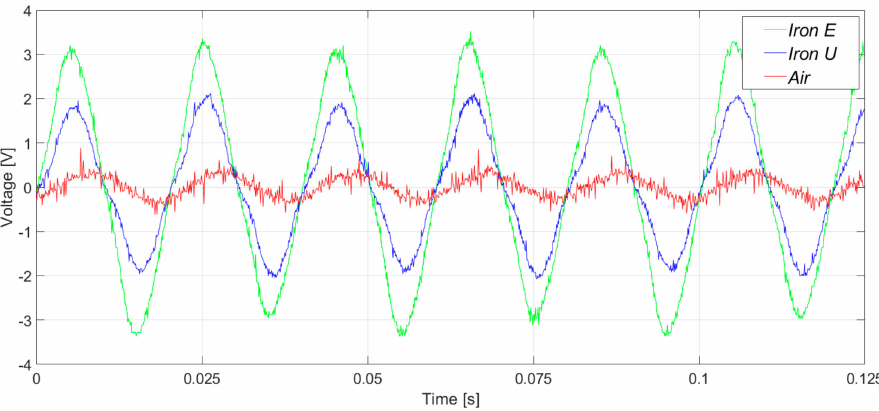
Figure 7. Induced voltage measurement in healthy conditions, in the right-side position.